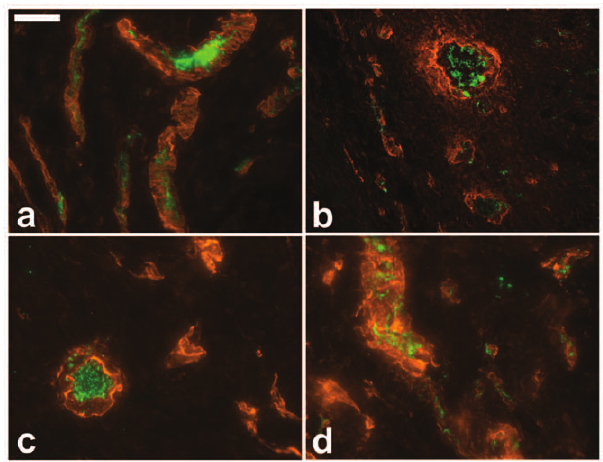
Figure 4. Microbead perfusion. High magnification (40 6 ) images within the MI region showing the perfusion of 0.2 m m fluorescent microbeads (green) into arterioles that have been stained using anti- a smooth muscle actin (orange) in hearts treated with ( a ) Ab-FC/HV, ( b ) Ab-RGD, ( c ) Ab-HepI, or ( d ) Ab-HepIII. Scale bar: 15 m m.